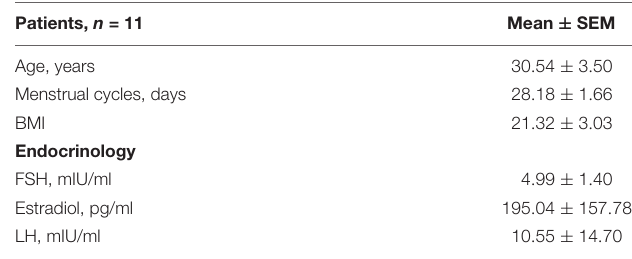
TABLE 1 | Clinical characteristics of transsexual